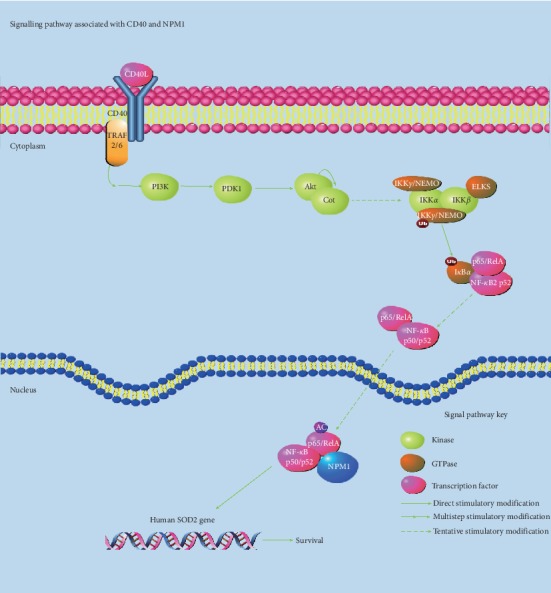
Analysis of signal pathways related to CD40 and NPM1.